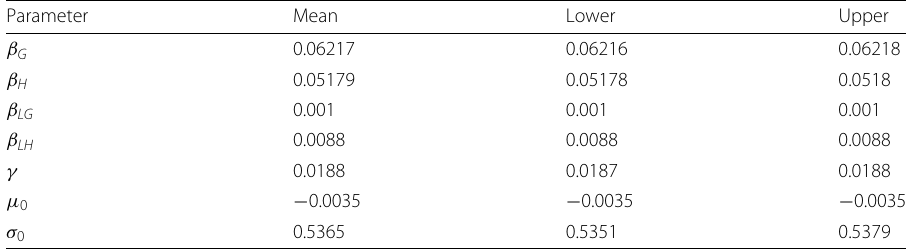
Table 4 Parameter estimates. Posterior mean and 99% posterior confidence intervals are reported Parameter Mean Lower Upper β G 0.06217 0.06216 0.06218 β H 0.05179 0.05178 0.0518 β LG 0.001 0.001 0.001 β LH 0.0088 0.0088 0.0088 γ 0.0188 0.0187 0.0188 − 0.0035 − 0.0035 − 0.0035 μ 0 σ 0 0.5365 0.5351